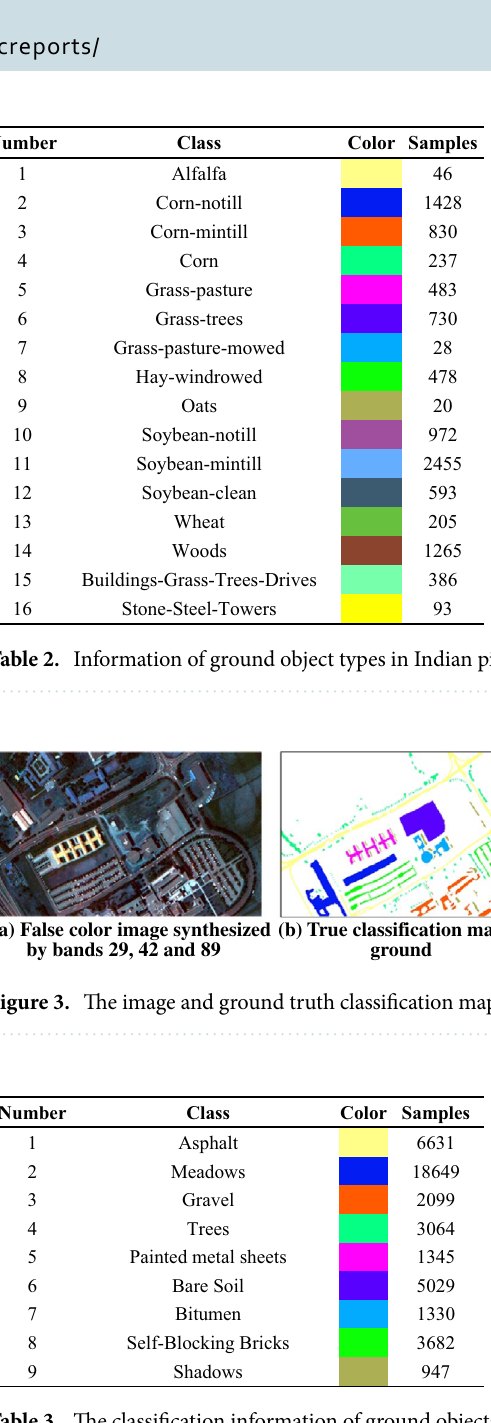
Table 3. The classification information of ground objects in Pavia university